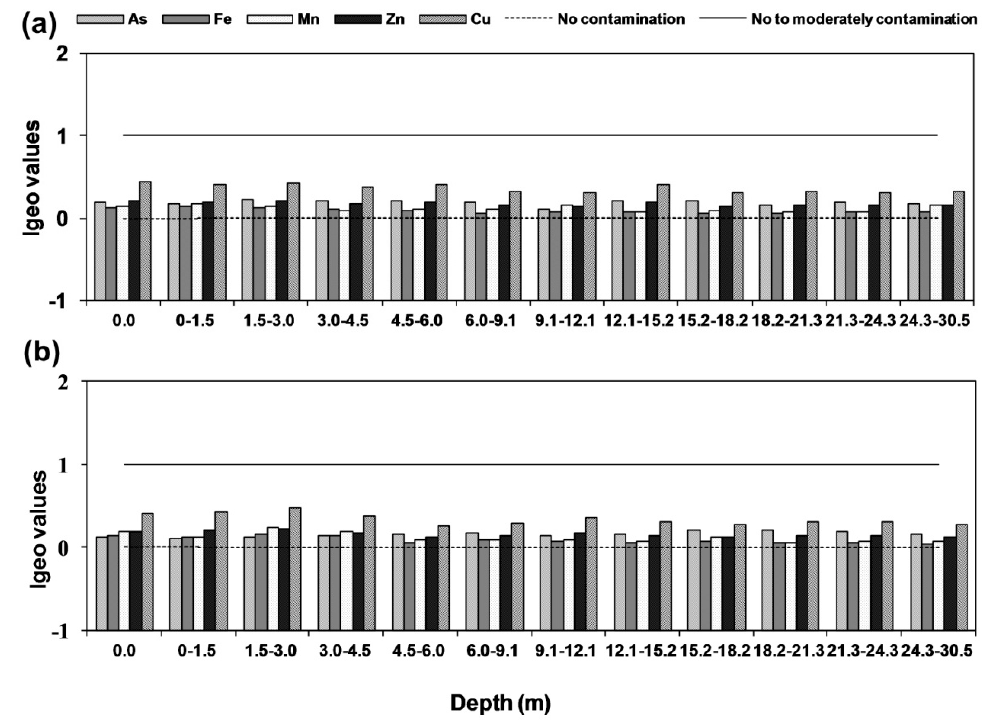
Figure 7. Calculated Igeo for As, Fe, Mn, Zn, and Cu ( a ) Rigni Chhapra ( b ) Chaube Chhapra.